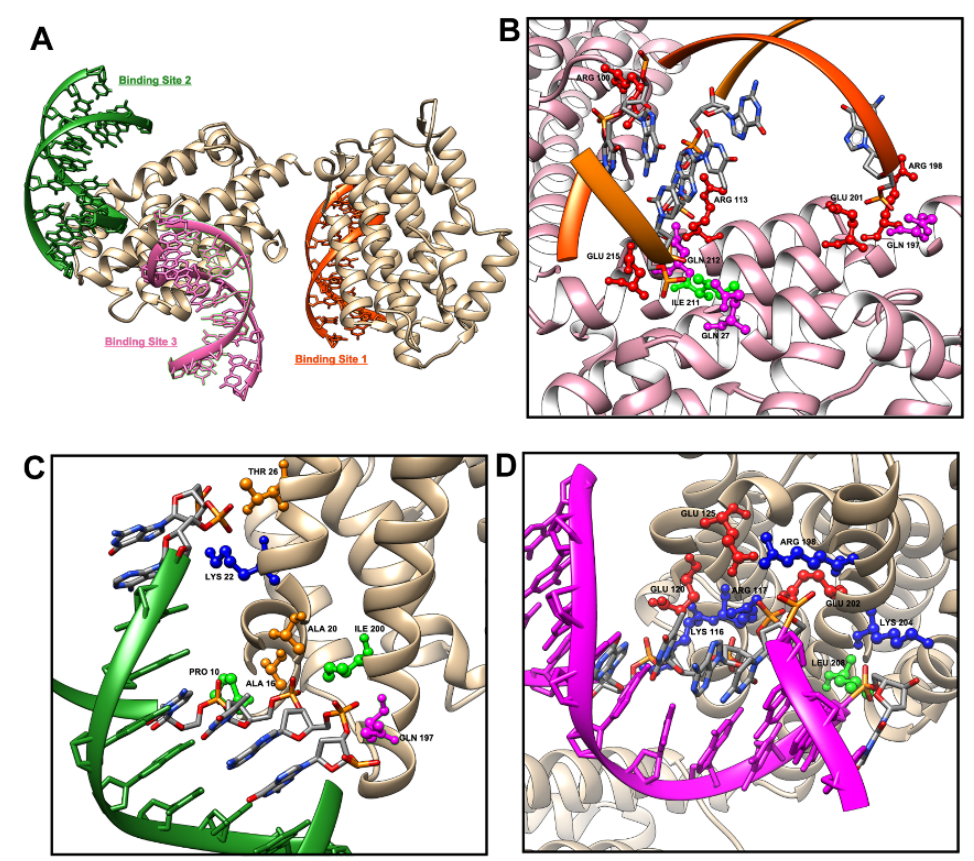
Figure 4. Predicted dsDNA binding sites on human apo HO-1 protein. ( A ) Three predicted dsDNA (10 bp binding fragments) binding sites on human apo HO-1 protein were presented. Binding site 1 was represented in orange color, binding site 2 was represented in green color and binding site 3 was represented in pink color. ( B ) Close view of binding site 1 contains 9 residues which contact with 7 DNA positions on a predicted dsDNA fragment. ( C ) Close view of binding site 2 contains seven residues which contact with 6 DNA positions on a predicted dsDNA fragment. ( D ) Close view of binding site 3 contains 8 residues which contact with 5 DNA positions on a predicted dsDNA fragment.